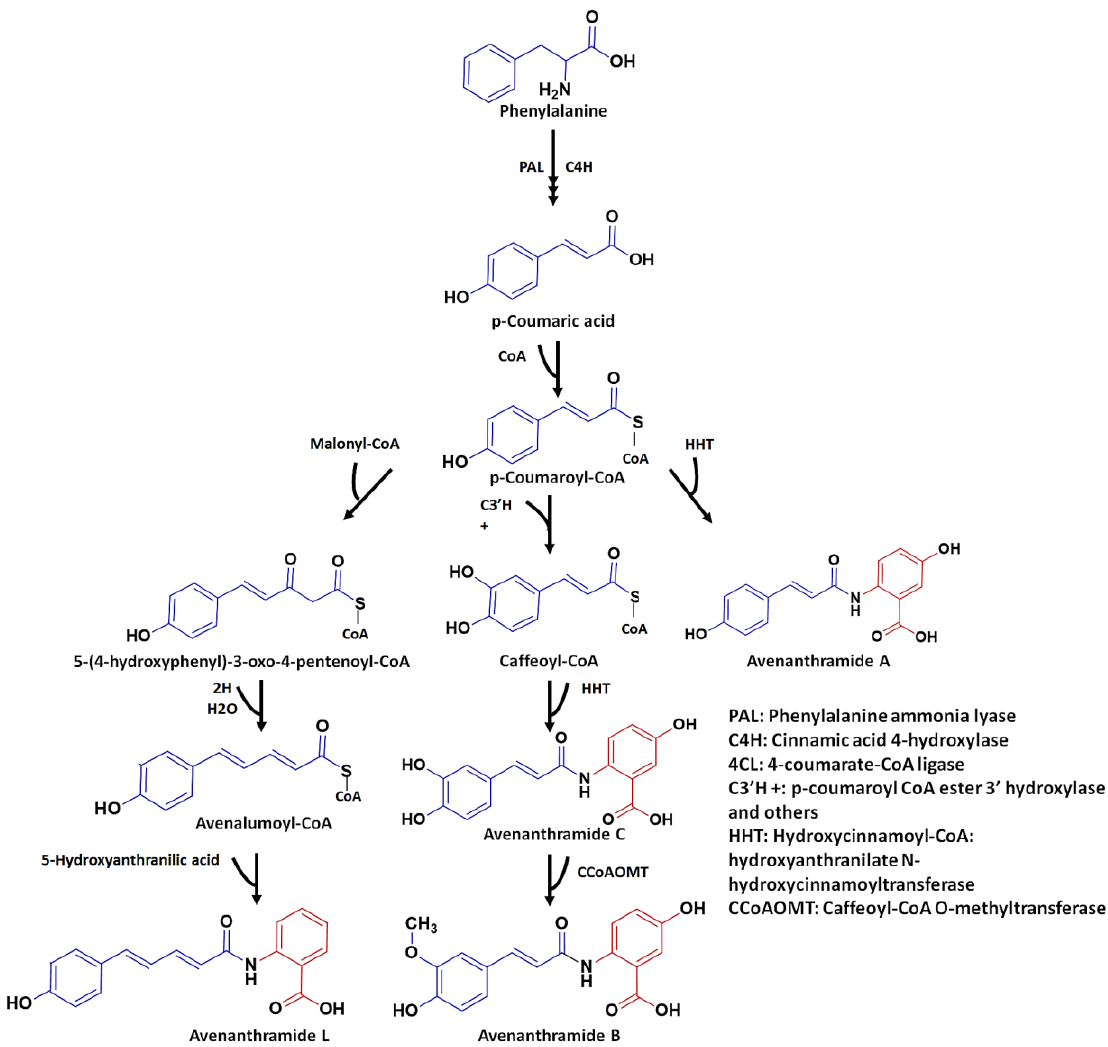
Figure 1. Schematic of the proposed biosynthetic pathway of the three major avenanthramides A, B, and C (hydroxycinnamic acid derivatives) and avenanthramide L (an avenalumin derivative) in oat, that are composed of an anthranilic acid (AA, red) and a phenylalkenoic acid (PA, blue). The PA moiety originates from the stress-inducible phenylalanine ammonia lyase in the early phe- nylpropanoid pathway, while the anthranilic acid originates from the shikimate pathway via choris- mate. The conjugating enzyme is a hydroxycinnamoyl CoA: hydroxyanthranilate N -hy- droxycinnamoyltransferase (HHT), that catalyses the N -acylation of hydroxyanthranilates with var- ious activated hydroxycinnamoyl-CoAs as aroyl-moieties, to form a series of Avns. Avns are thus N -cinnamoylanthranilic acids; with p-coumaroyl-CoA yielding Avn A and caffeoyl-CoA